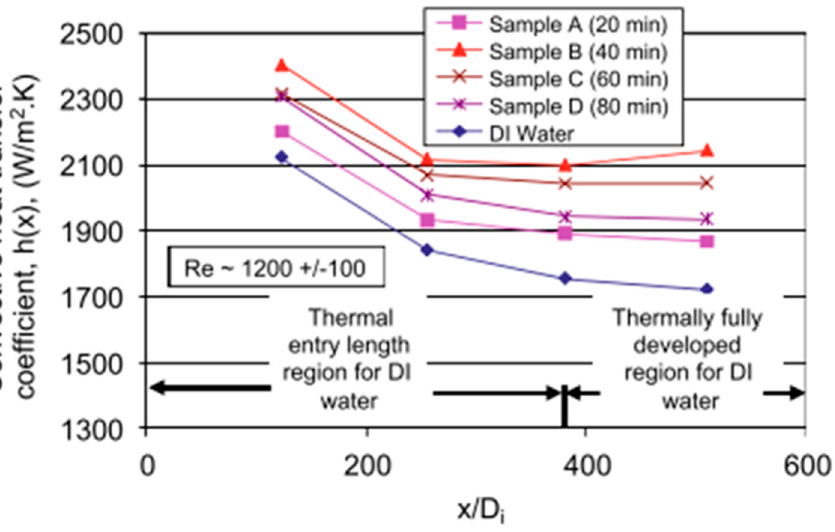
Figure 7. Influence of sonication duration on convective heat transfer coefficient (Re = 1200) of aqueous nanofluid. Adapted from [127].